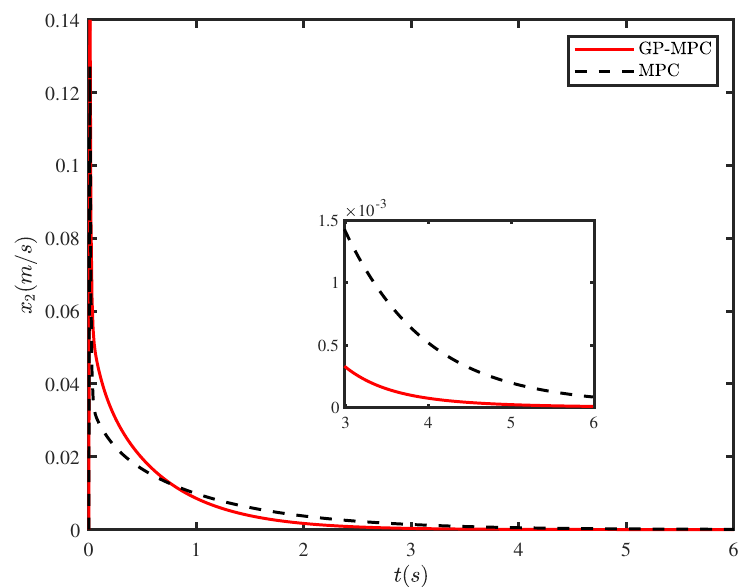
Figure 8. The speed under different control strategies.